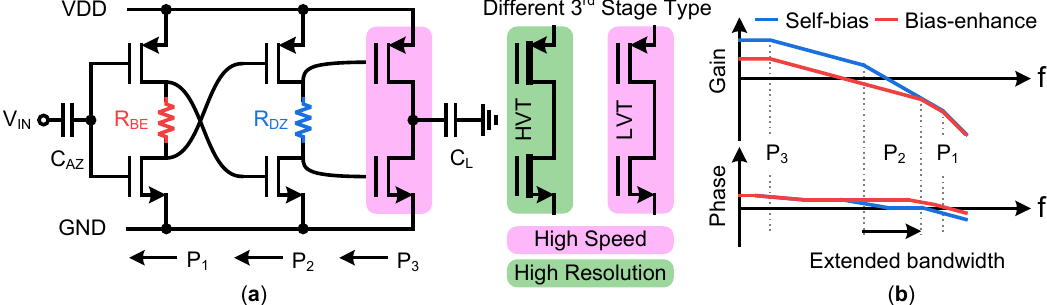
Figure 2. Proposed bias-enhanced ring amplifier for high-speed ADC: ( a ) The schematic of the basic three-stage ringamp and the different configuration in the 3rd stage for various applications; ( b ) The conceptual bode plot to explain the bandwidth extension by the proposed bias-enhanced